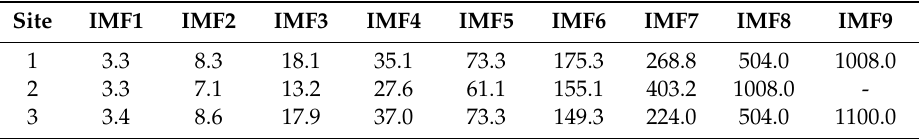
Table 2. The periods of all intrinsic mode function (IMF) components.